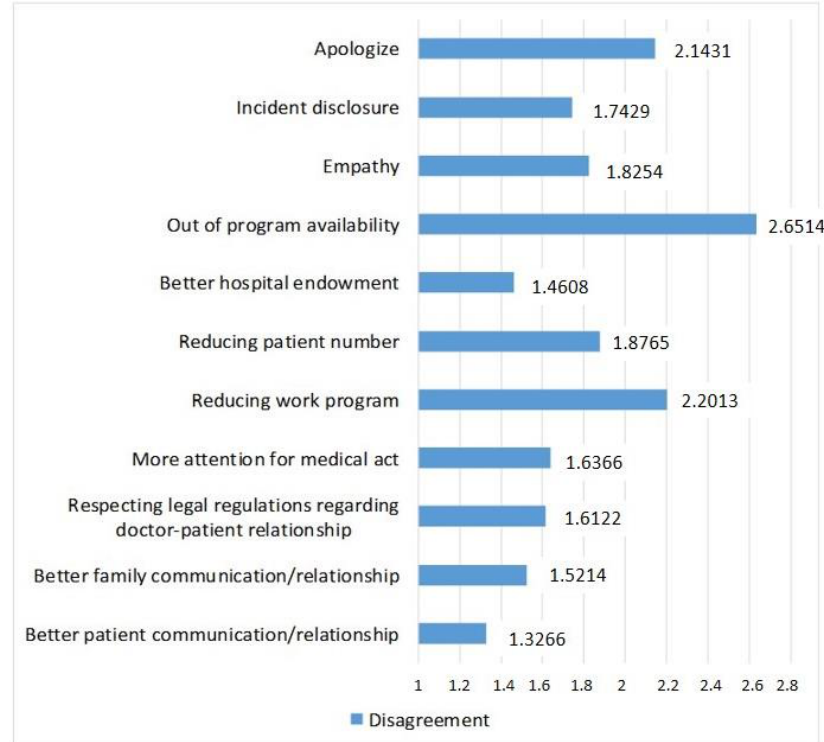
Figure 3. Elements that could protect against a malpractice complaint.